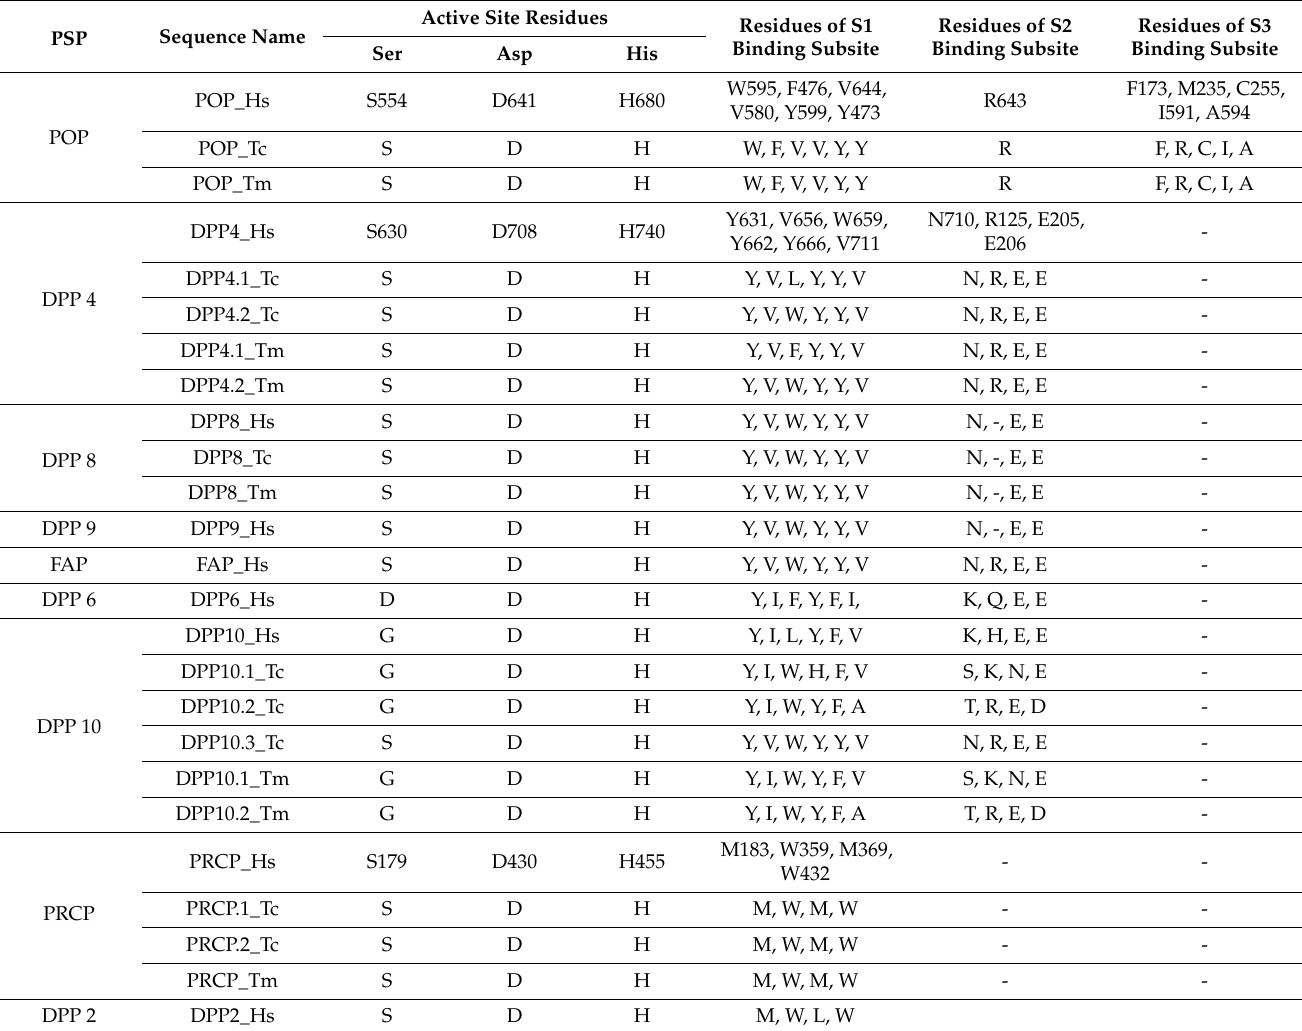
Table 2. General characteristics of the serine PSP sequences from the S9 and S28